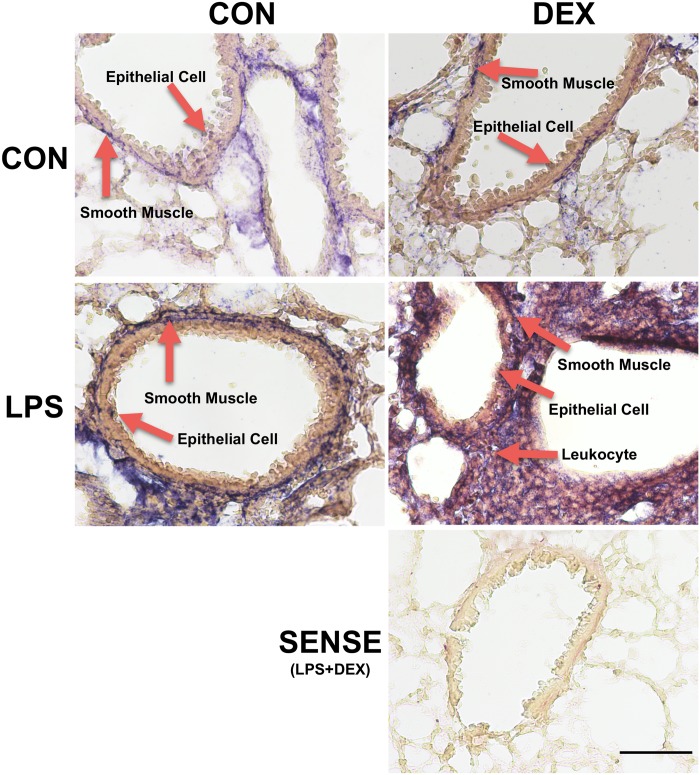
Representative in situ hybridization results on lung sections.In situ hybridization using a mouse G-CSF anti-sense RNA probe detected G-CSF production locally in lungs of animals treated with vehicle (CON), dexamethasone (DEX, 2.5 mg/kg, i.p., 18 h), LPS (1 mg/kg, i.t., 24 h), and LPS+DEX (6 h post LPS). Cell types with positive signals include smooth muscle cells, epithelial cells, and infiltrated leukocytes (arrows). Control hybridization slides were processed using the sense strand of the RNA probe. Scale bar, 1 mm.